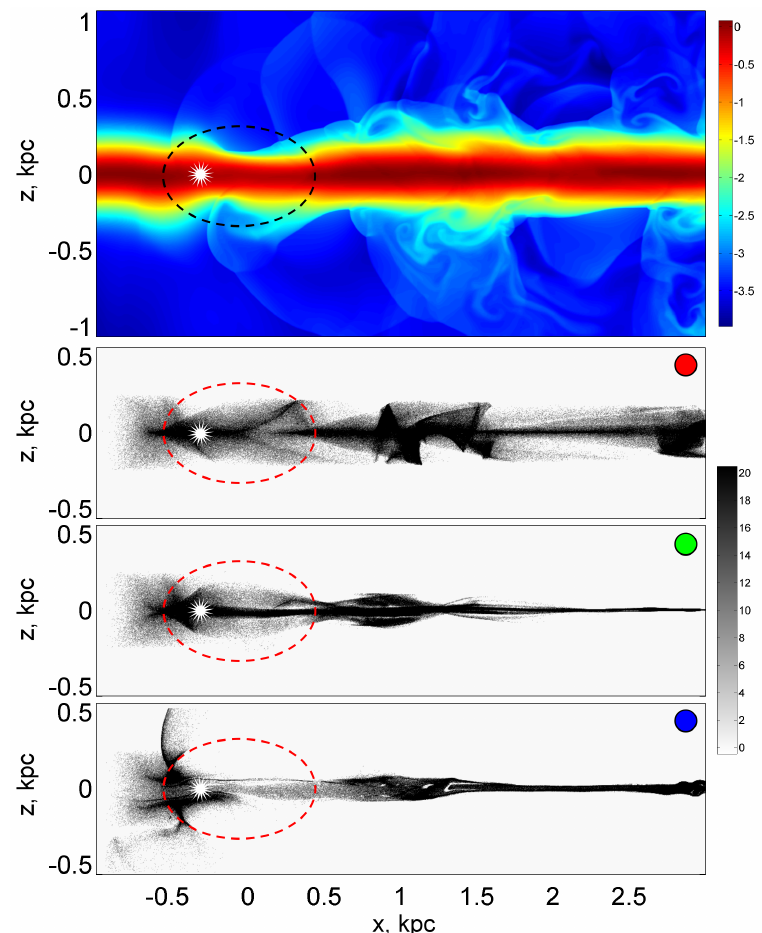
Figure 1. Distributions of the gas density (logarithmic scale), normalized to the initial value of the density ρ 0 , in the gas disk of the galaxy (top color figure) and concentration (in the number of particles per computational cell) for the fractions of large (figure with a red marker), medium (figure with a green marker), and small (figure with a blue marker) dust particles. The dashed ellipse shows the contour of the spiral arm, and the asterisk indicates the position of the radiation